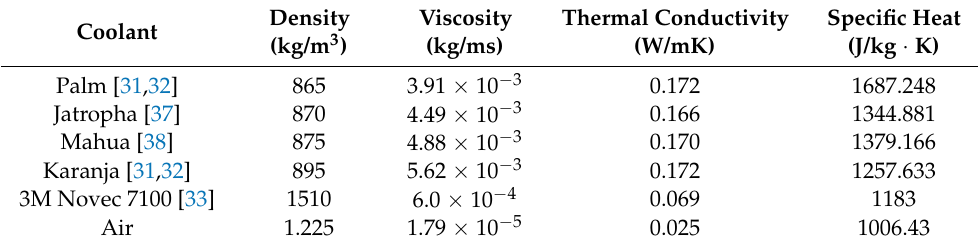
Table 3. Key Thermodynamic Properties of Cooling